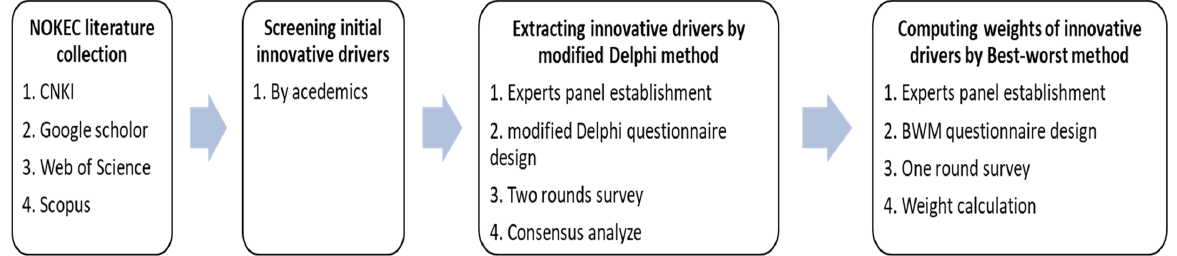
Figure 2. Overview of integrated modified Delphi–BWM.